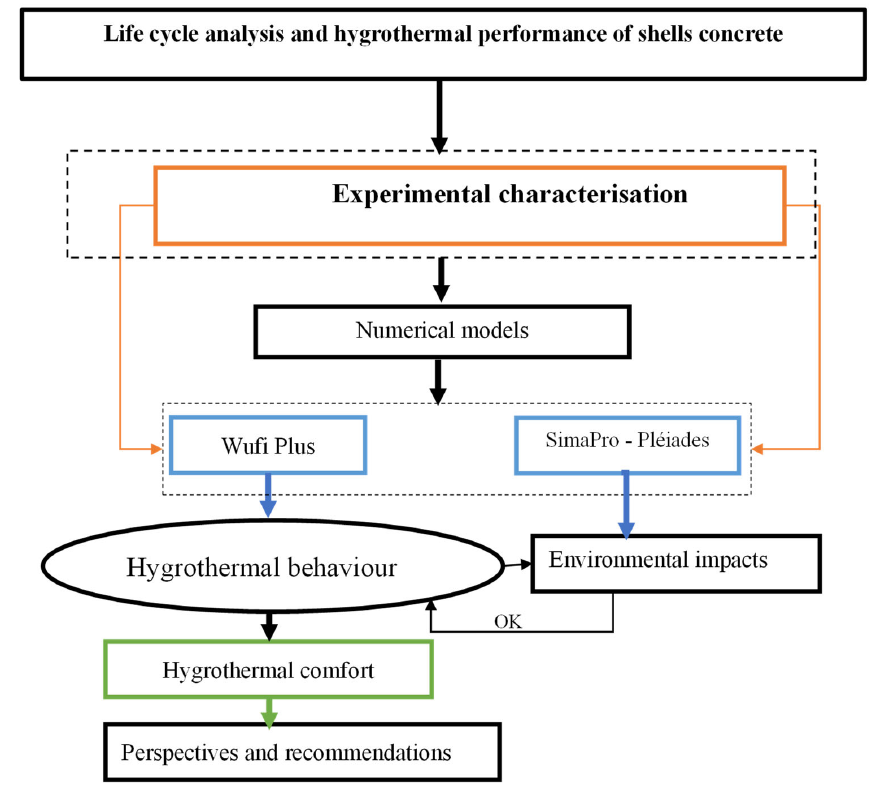
Figure 1. Conceptual study plan.